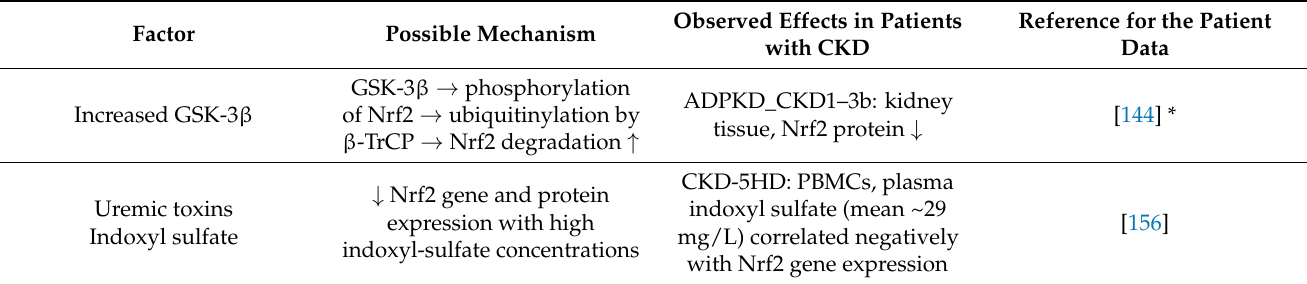
Table 2. Factors and mechanisms relevant for endogenous Nrf2 repression in human